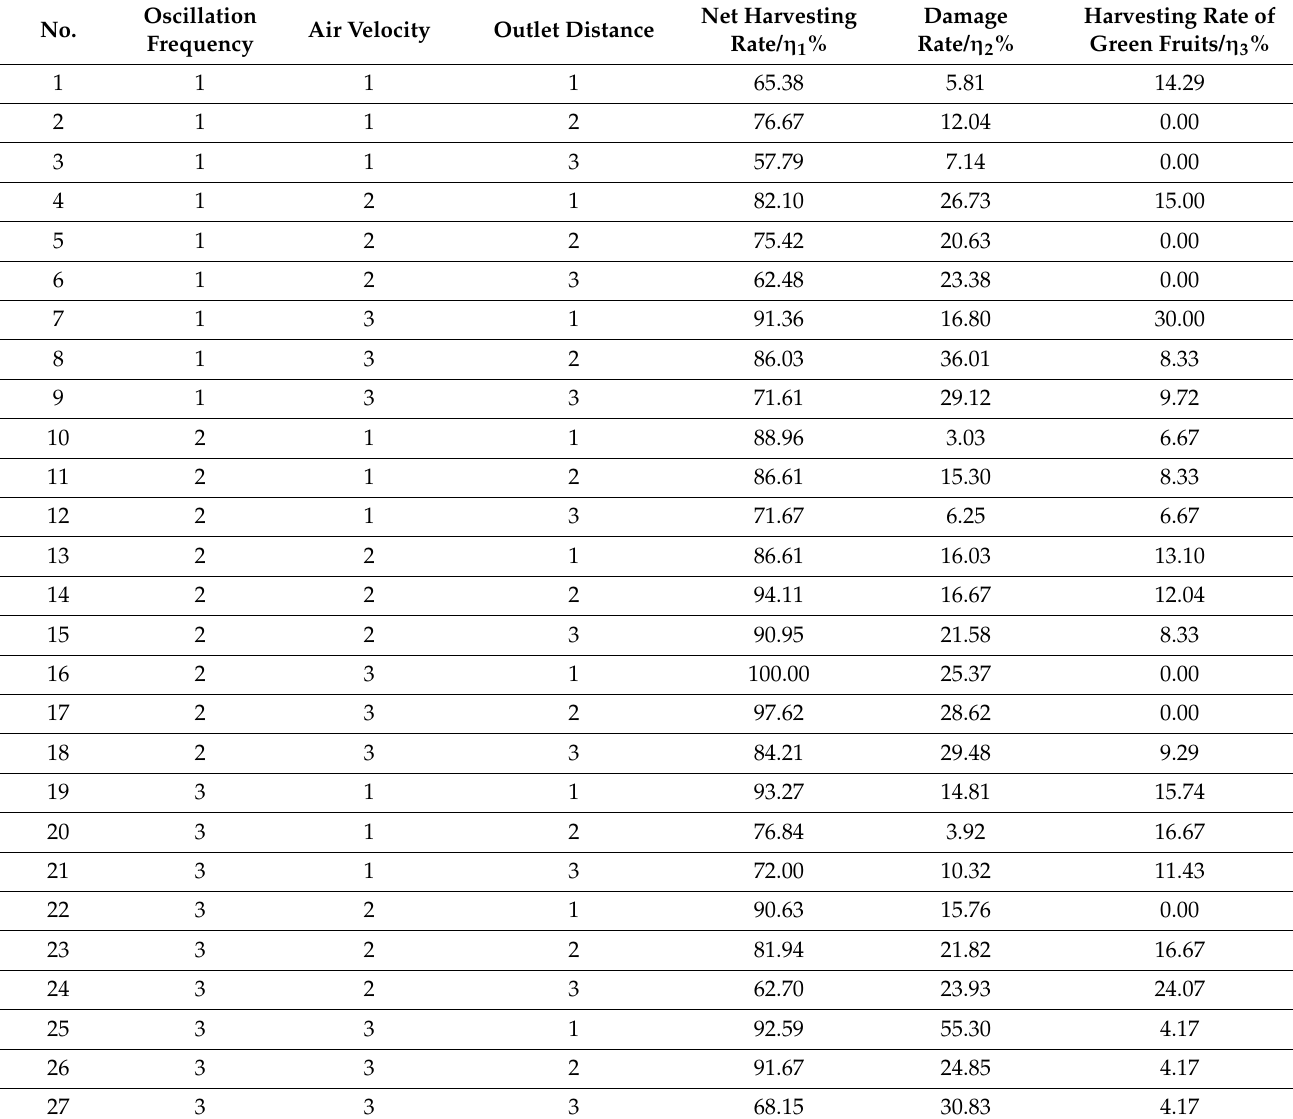
Table 4. Test arrangements and